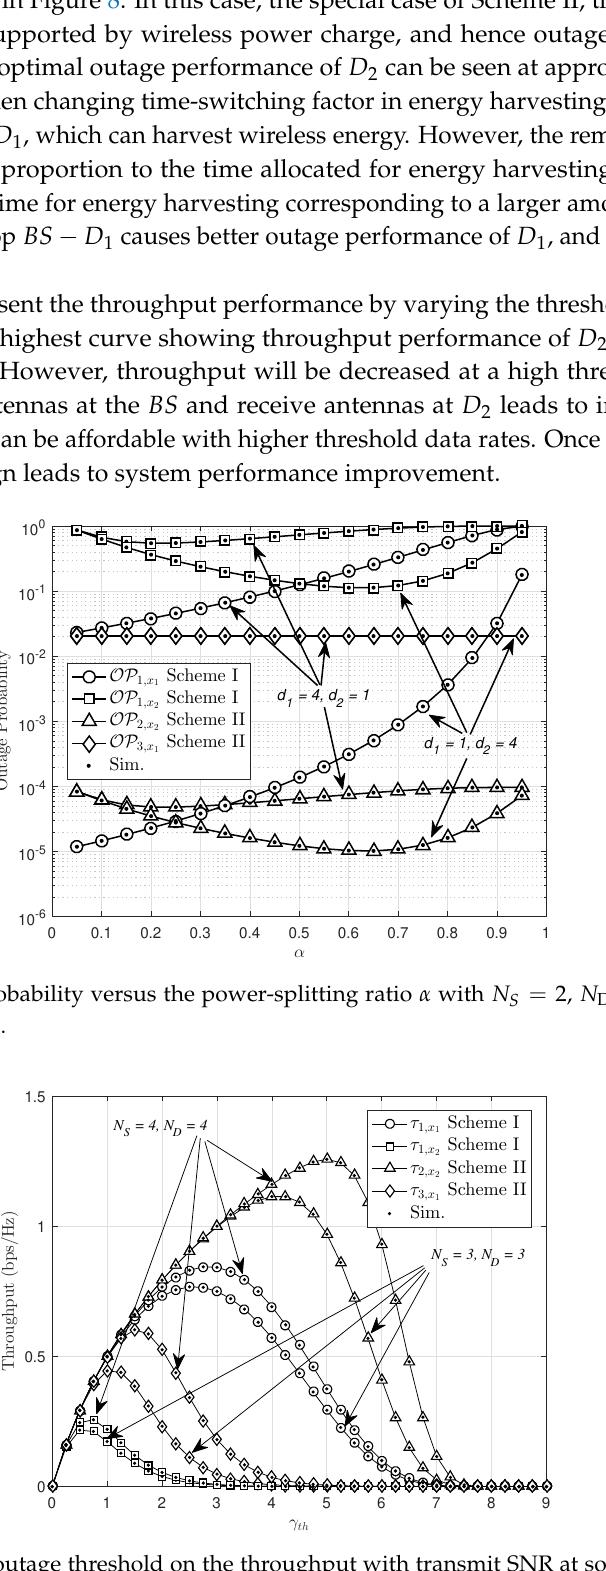
Figure 9. Impact of outage threshold on the throughput with transmit SNR at source SNR = 20 dB , d 0 = 5 m, d 1 = 3 m, d 2 = 2 m, a 1 = 0.1 and a 2 =